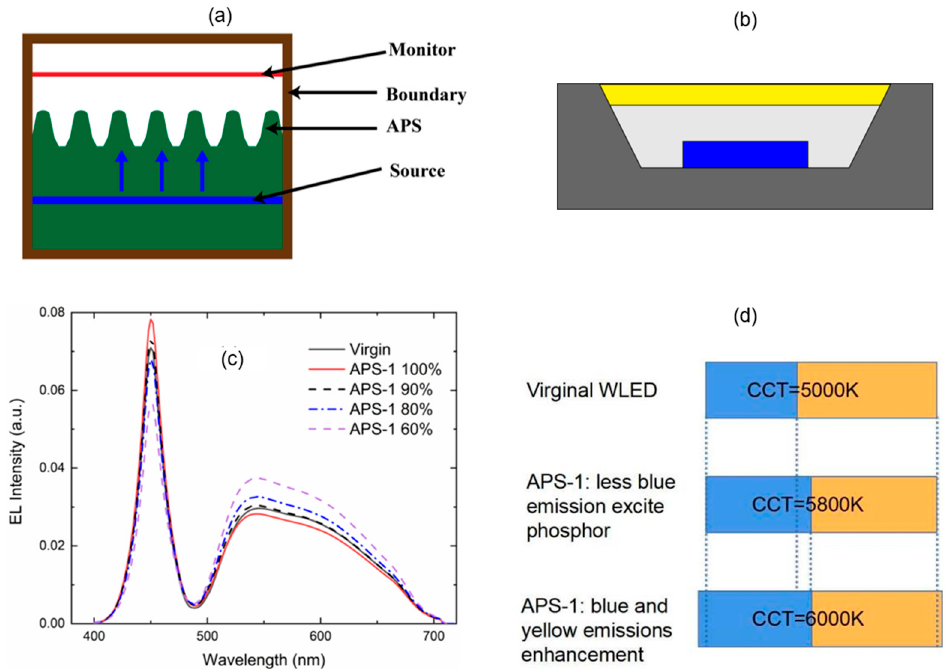
Figure 5. ( a ) The schematic diagram of white LED with APS in the FDTD simulation. ( b ) The white LED model in the ray tracing simulator. ( c ) Simulated EL spectra of white LEDs with APS with different blue emission transmission ratios. ( d ) The diagrammatic sketch of LE enhancement of white LED by APS-1 mounted.